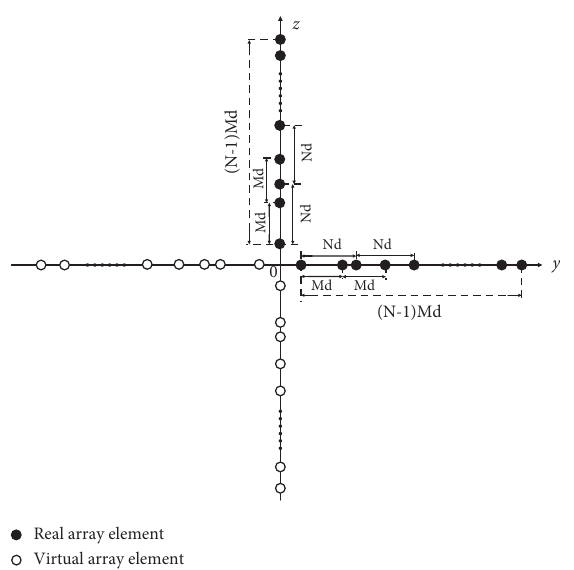
Figure 6: The schematic diagram after virtual